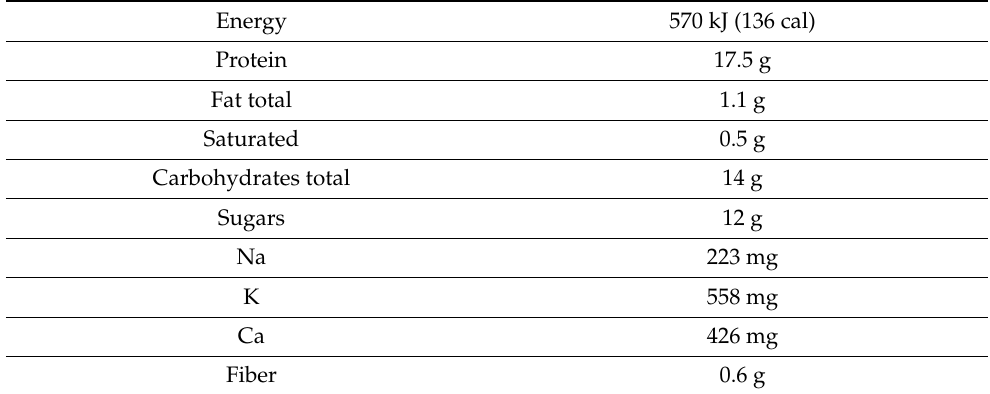
Table 1. Nutritional composition of 100 mL of the protein shake beverage used in this